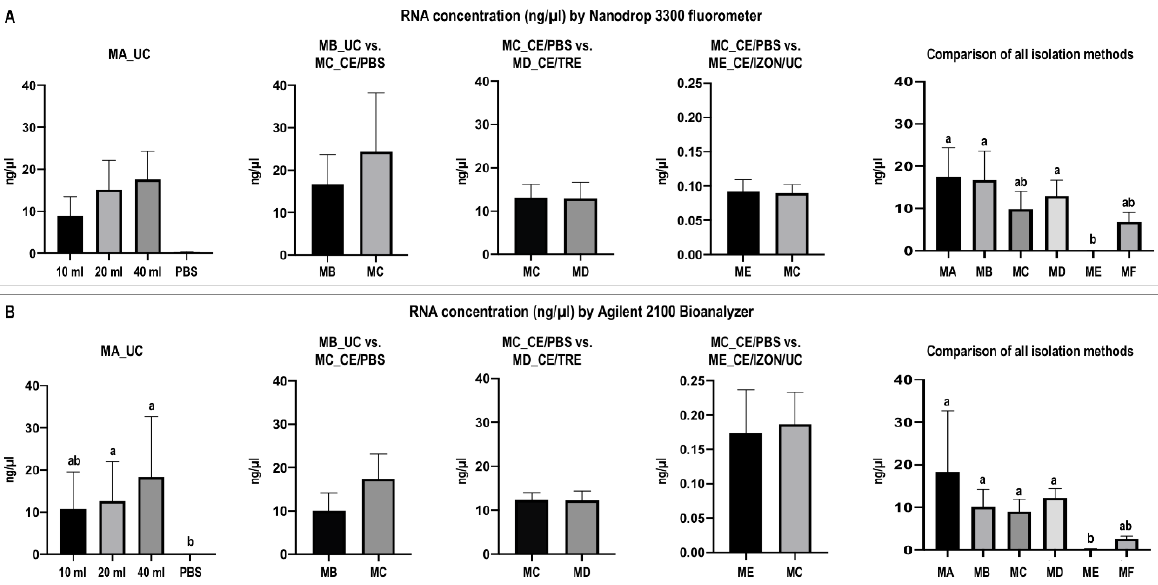
Figure 8. RNA concentration of equine uterine extracellular vesicles (EVs) isolated by different methods. ( A ) RNA concentration of EVs measured by Nanodrop 3300 fluorometer. ( B ) RNA concentration of EVs measured by Agilent 2100 Bioanalyzer. Different letters indicate significant differences among EVs isolation methods. (a,b: p < 0.05). Method MA_UC: EVs obtained by ultracentrifugation (UC) using fixed angle rotor starting from 10, 20, and 40 mL uterine lavage sample or using PBS as a control; MB_UC: EVs obtained by UC with swing-out rotor; MC_CE/PBS: ultrafiltration by using Centricon filters and subsequent UC with swing-out rotor; MD_CE/TRE: EVs obtained by ultrafiltration with washing step with PBS/25mM trehalose and subsequent UC with swing-out rotor; ME_CE/IZON/UC: EVs obtained by ultrafiltration followed by size exclusion chromatography (Izon qEV columns, collection of fractions 7,8,9 enriched in EVs and concentration of EVs fractions by UC swing-out rotor; MF_CE/TRE/IZON/UC: CE with PBS/25 mM trehalose wash step, Izon qEV columns and UC.